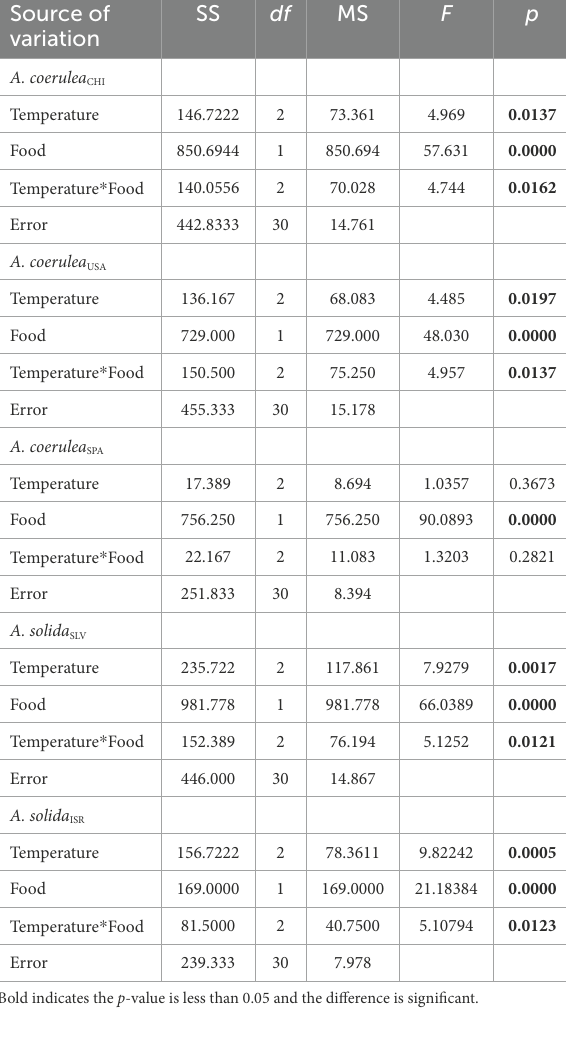
TABLE 1 Results of two-way ANOVA examining the effects of temperature and food supply on asexual reproduction rates of Aurelia scyphistomae